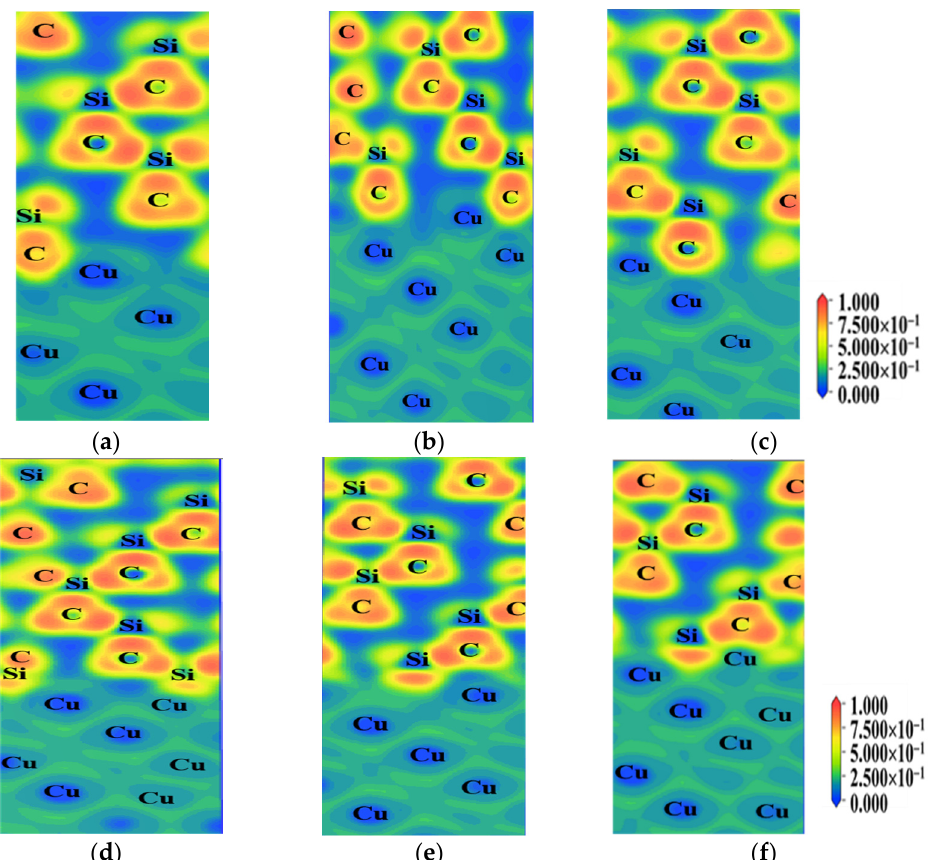
Figure 7. Electron localization function of the interfacial atoms of all “(a)” types of 6H-SiC(0001)/Cu(111) interfacial models along (211) interface (eV/Å 3 ). ( a ) CT-HCP(a); ( b ) CT-MT(a); ( c ) CT-OT(a); ( d ) ST-HCP(a); ( e ) ST-MT(a); ( f ) ST-OT(a).